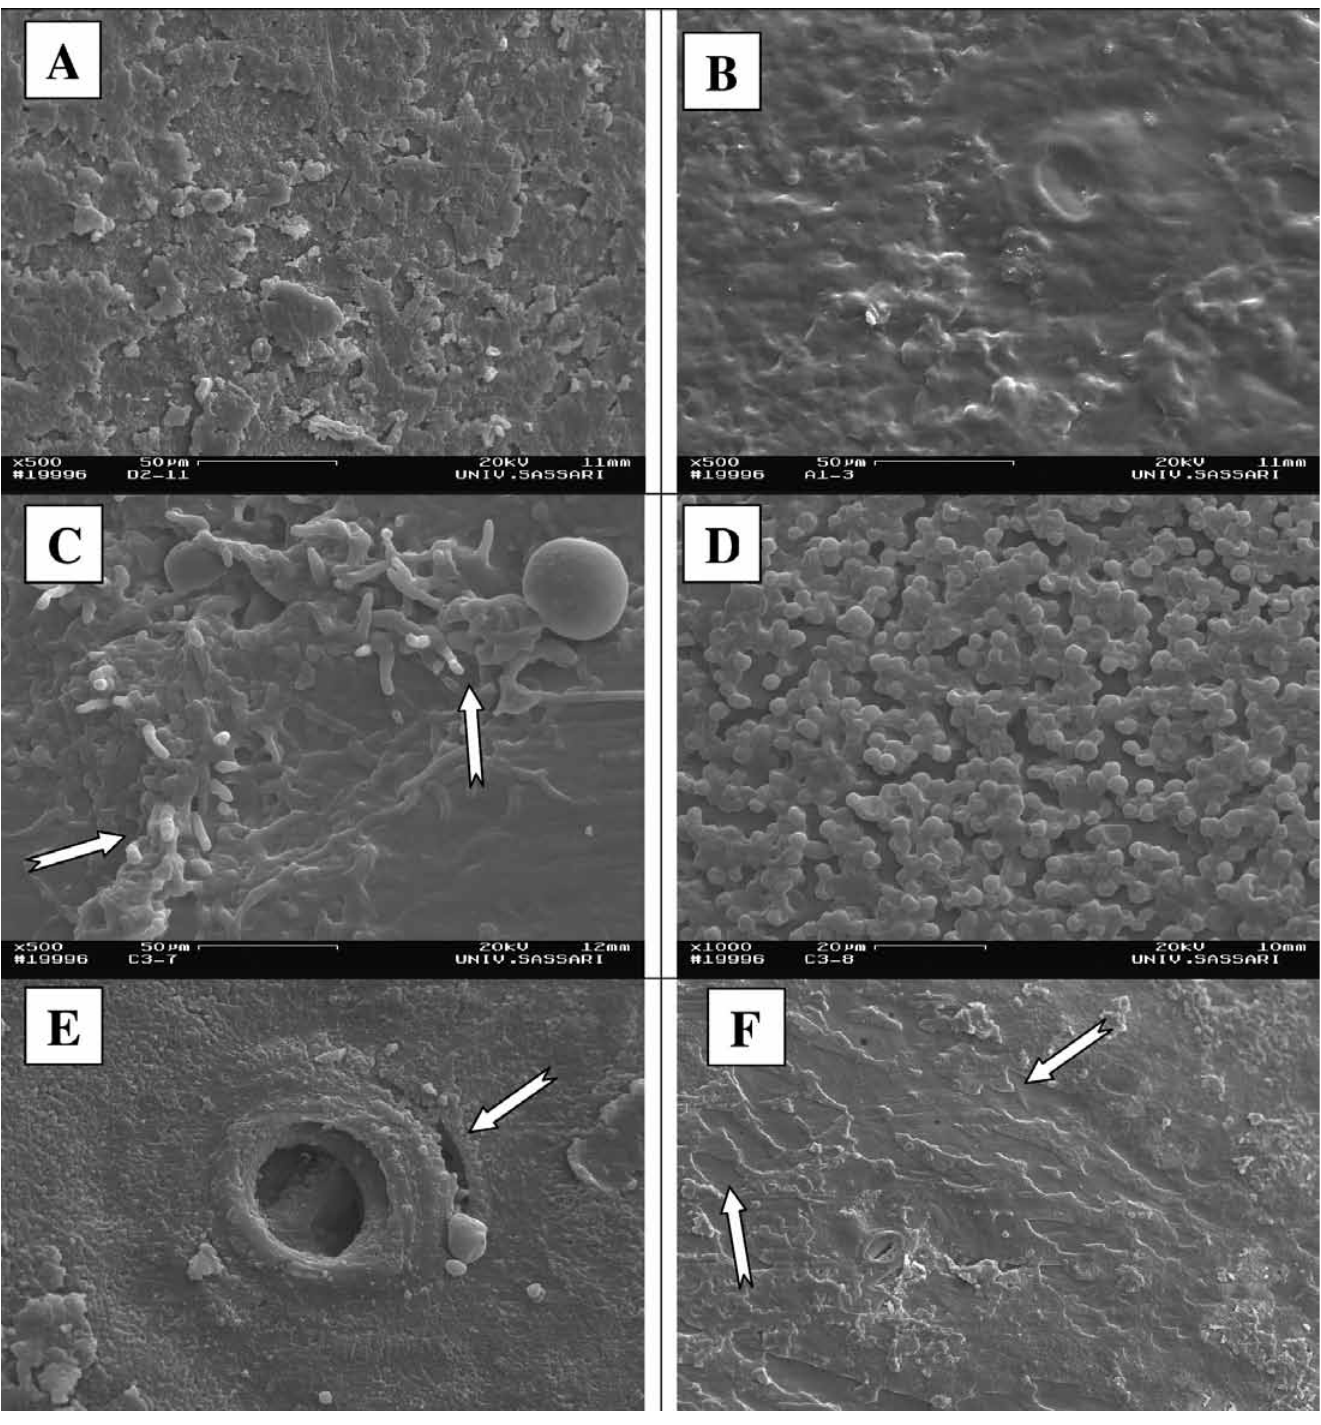
Fig. 3 - Micrographs A-F . Scanning electron microscopy micrographs of ‘Meloni’ prune epicuticular wax at harvest (A), following immersion at 55°C for 60 s in water (B) and in a 2% NaHCO solution (C) with arrows indicating crystalline wax (C), and a magnification of the new 3 wax layer (D). In micrograph ‘E’ damage to the cuticle and wax erosion (F) following immersion at 60°C for 60 s in the 2% SBC solution are evidenced